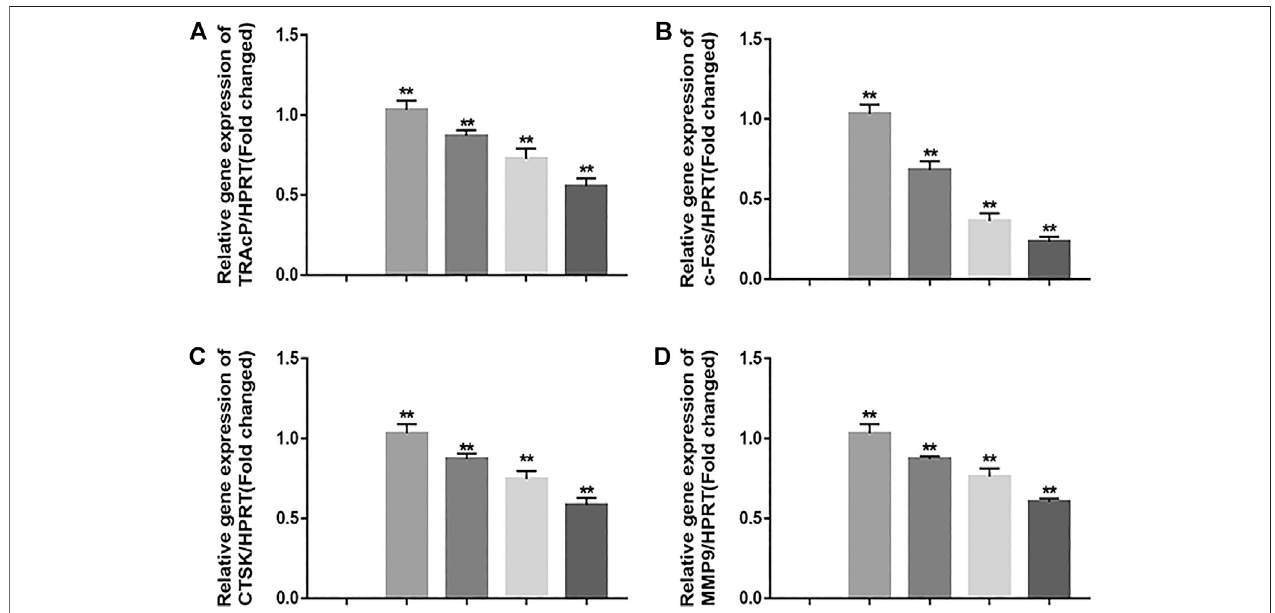
FIGURE 4 | JUG suppresses osteoclastogenic gene expression. (A – D) Real-time PCR analysis showing that down-regulates the expression of osteoclastogenic genes c-Fos, TRAcP, MMP9 and CTSK. The expression levels of these genes were normalized to the expression of HPRT. Data are presented as the mean ± SEM, * p < 0.05, ** p < 0.01 relative to the control group. n (cid:2)